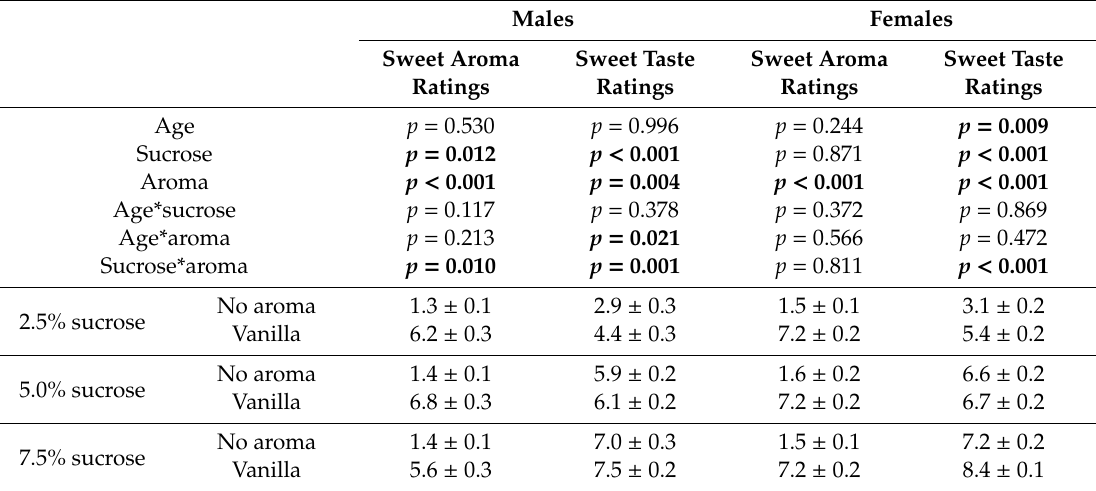
Table 3. Means ± std. errors for the ratings of sweet aroma and sweet taste intensity for males and females, respectively, as well as p -values for the factors in the models. Significant e ff ects are marked in